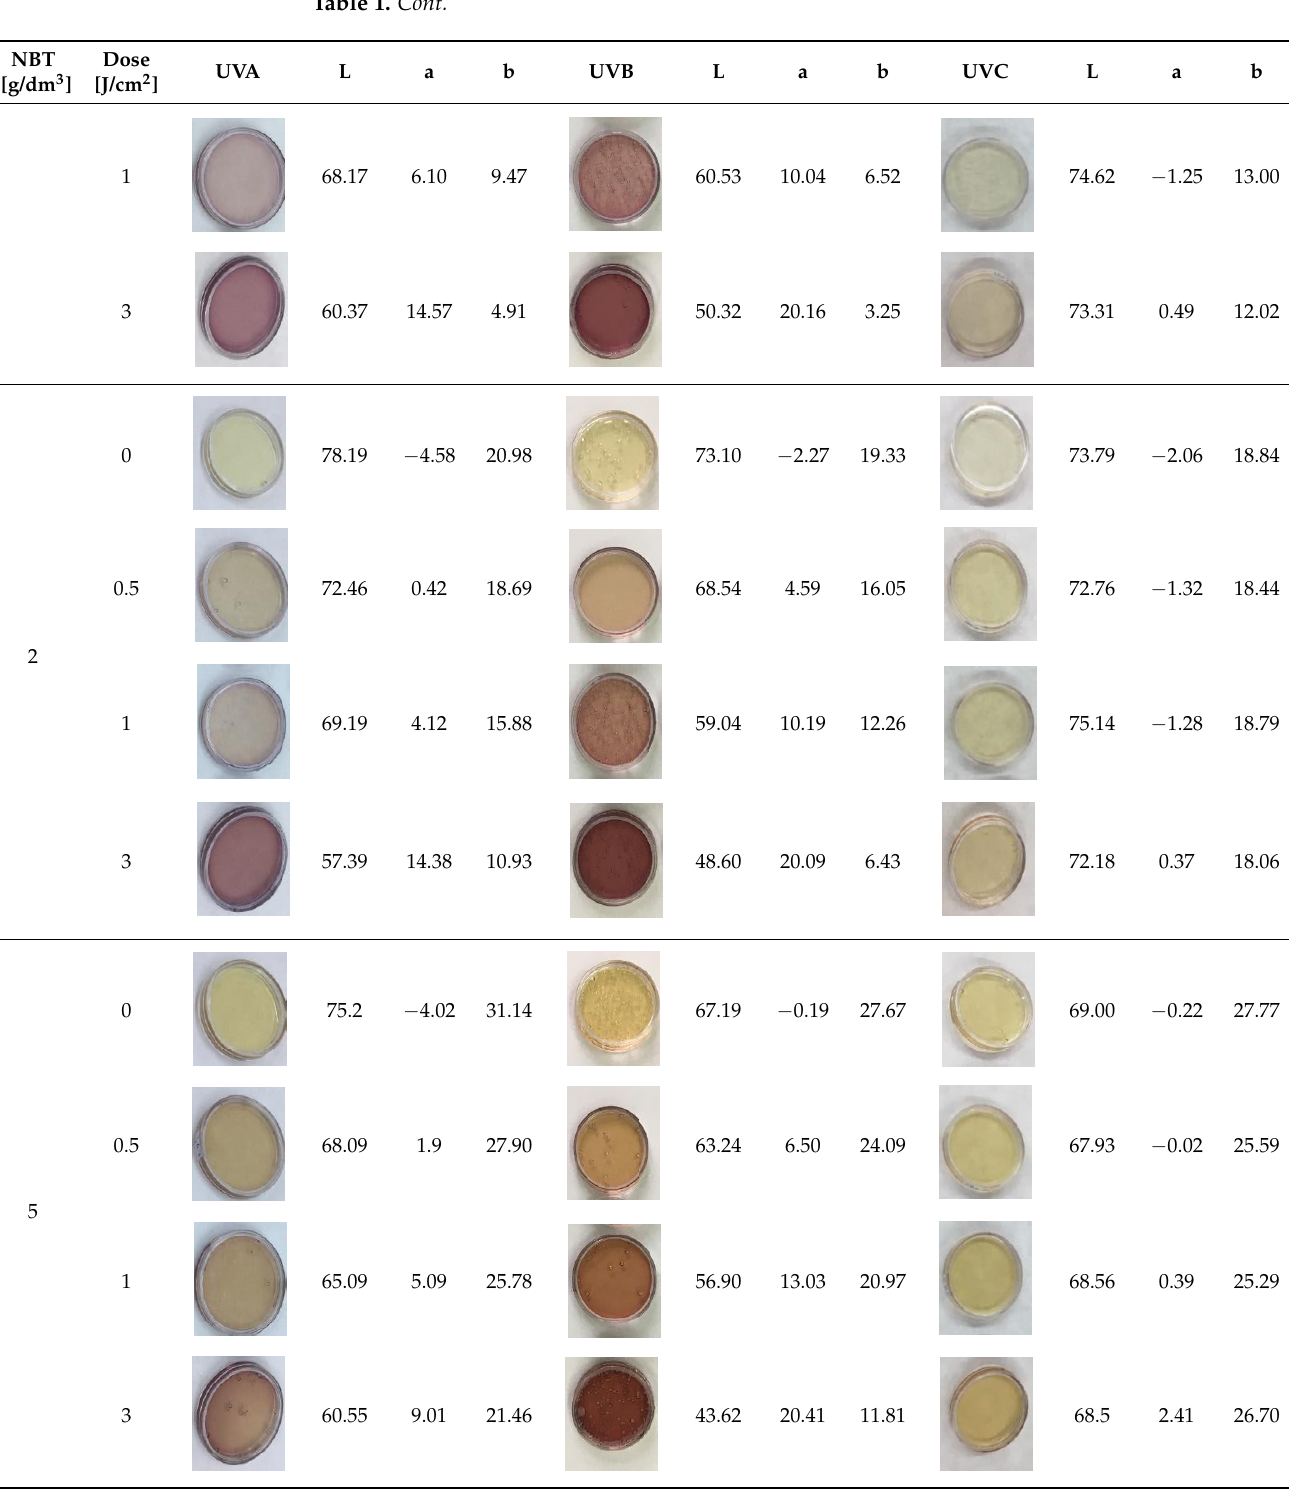
Table 2. Basic characteristics of NBT – Pluronic F – 127 dosimeters.